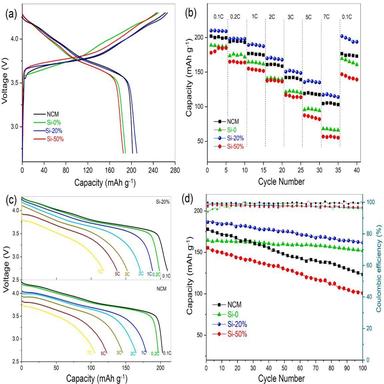
(a) Charge/discharge platforms of NCM, Si-0, Si-20 % and Si-50 % at 0.1C; (b) Rate capability of all samples; (c) rate performance of Si-20 %; (d) long-term cycling of at 1C.